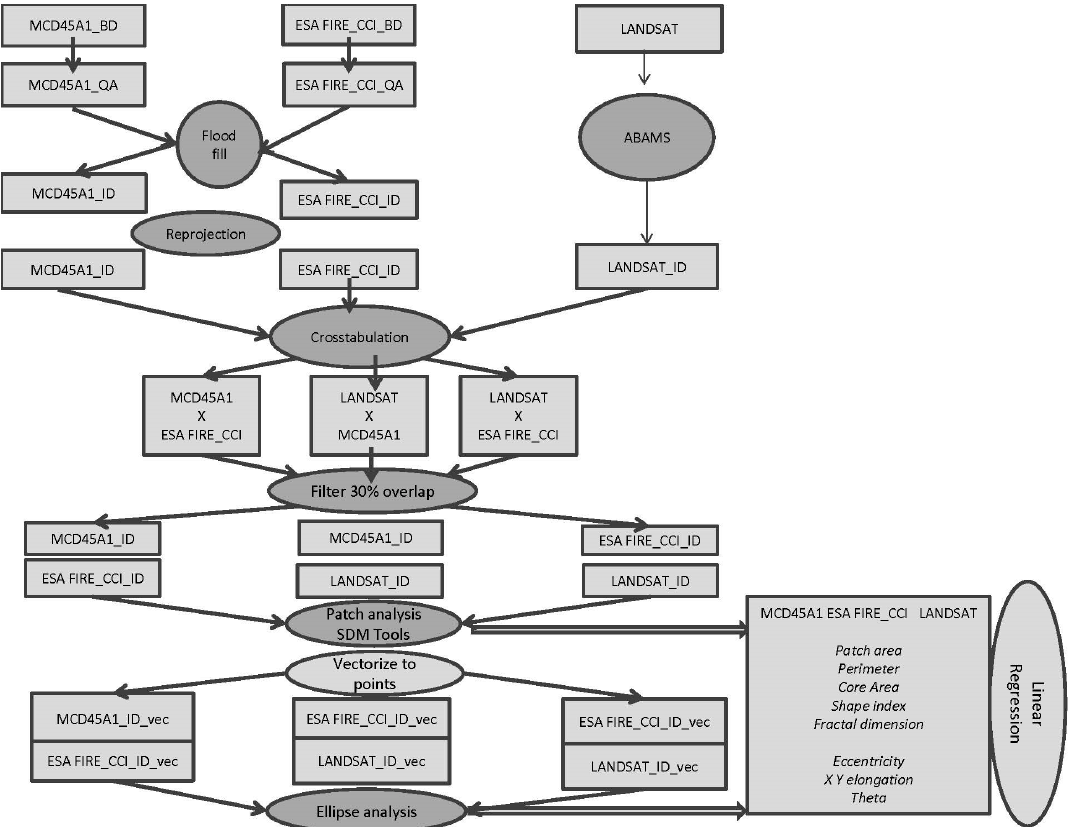
Figure 4. Flowchart of the fire data processing from (i) the raw data on burn date (BD) and Quality Assessment (QA) for the MODIS MCD45A1 and ESA FIRE_CCI pixel level fire products, the LANDSAT images and their processing into fire patches with the ABAMS software [30] as previously performed for this study site [20], (ii) the flood fill algorithm allowing pixel aggregation into patches identification (ID) according to their burn date, (iii) the crosstabulation of fire patches between fire products, the selection of patches overlapping over more than 30% of their surface, (iv) the calculation of patch morphological metrics and (v) the final correlation analysis using a linear